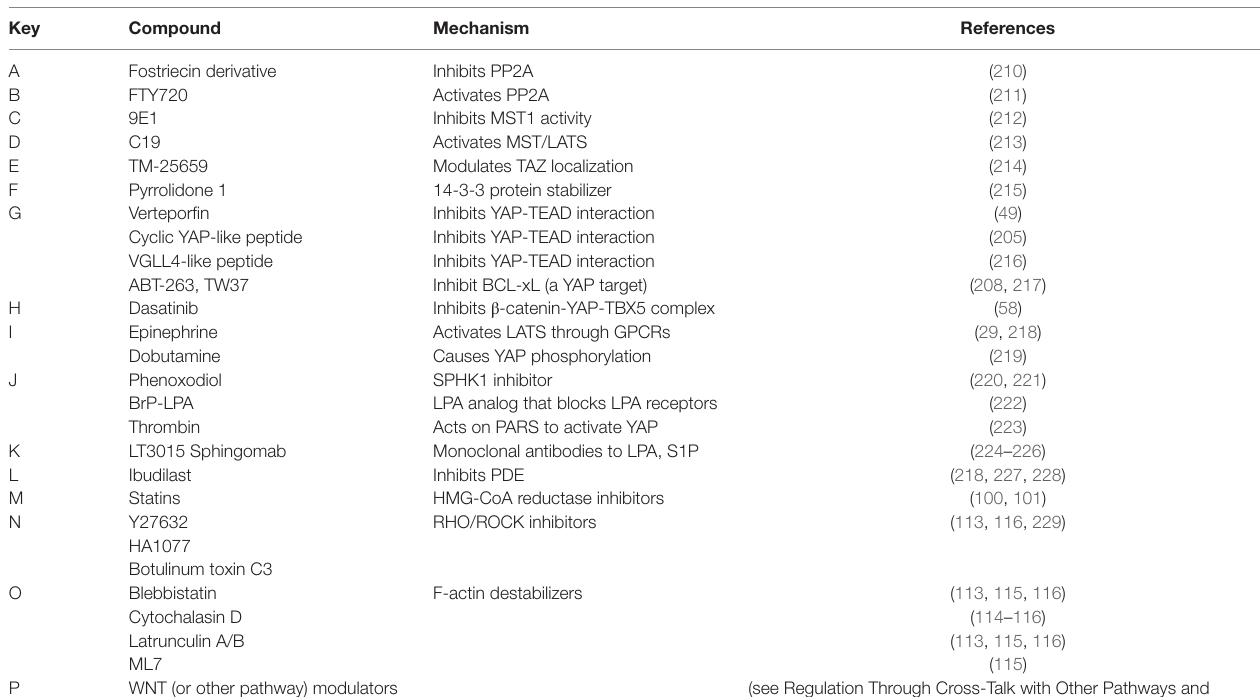
TABLe 3 | Pharmacologic modulators of the Hippo